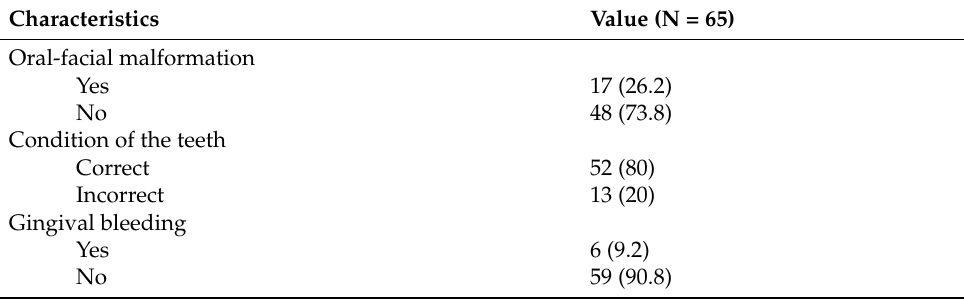
Table 3. Oral health status characteristics of cerebral palsied